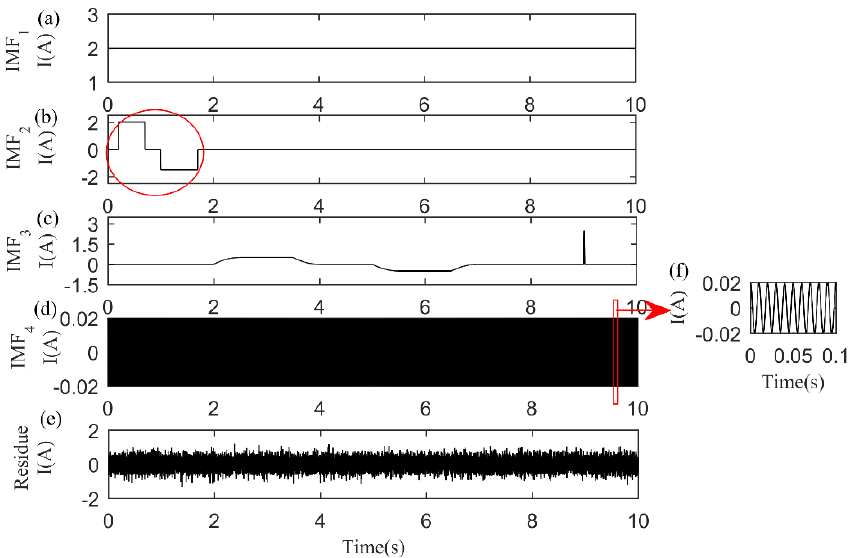
Figure 15. EEMD decomposition diagram under the noise of SNR 5. ( a ) IMF 1 component; ( b ) IMF 2 component; ( c ) IMF 3 component; ( d ) IMF 4 component; ( e ) Residue.